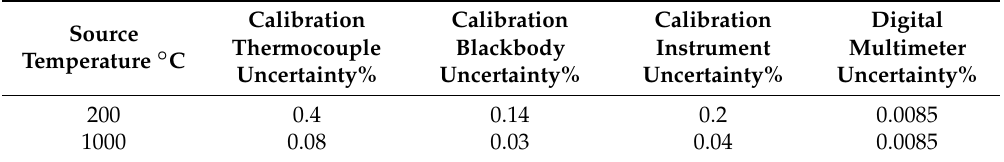
Table 1. Contributions of calibration uncertainties to overall measurement uncertainty.